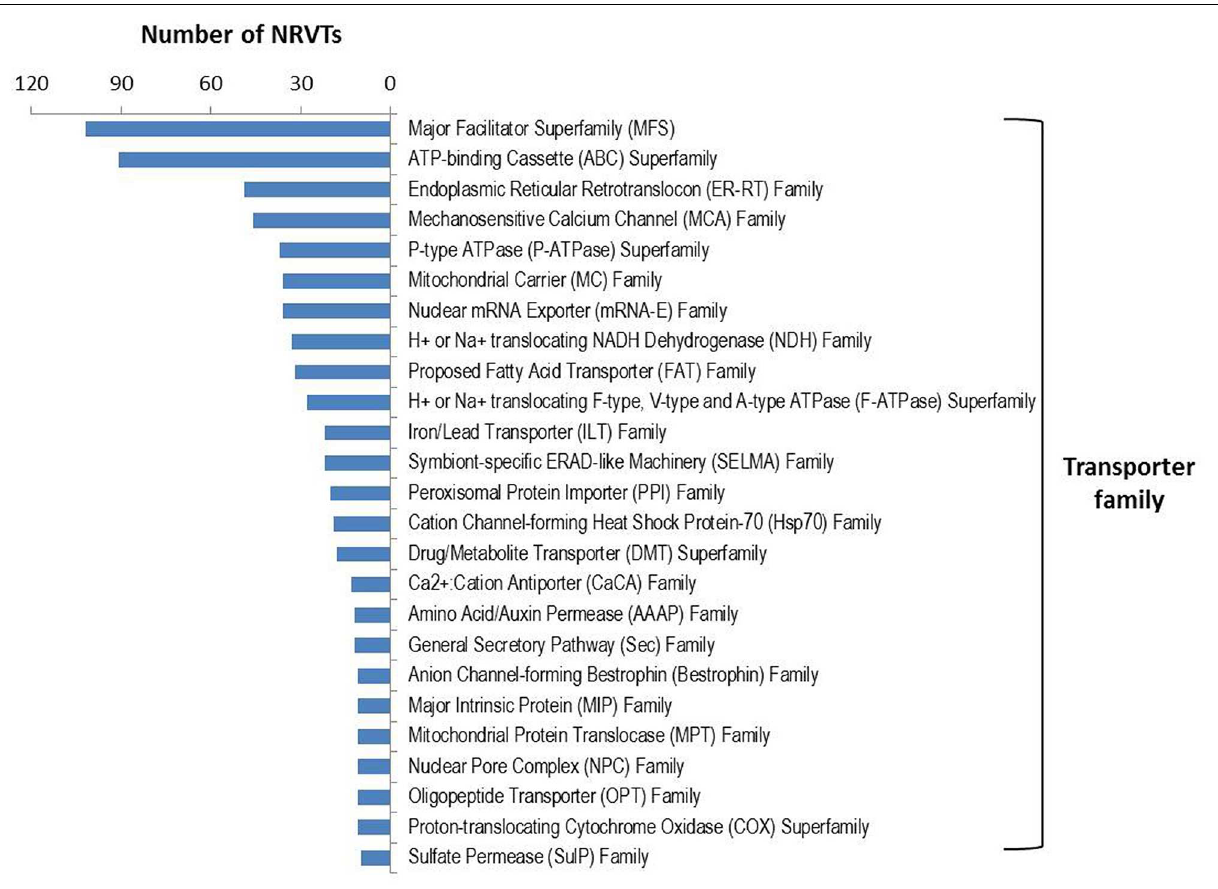
Frontiers in Microbiology |